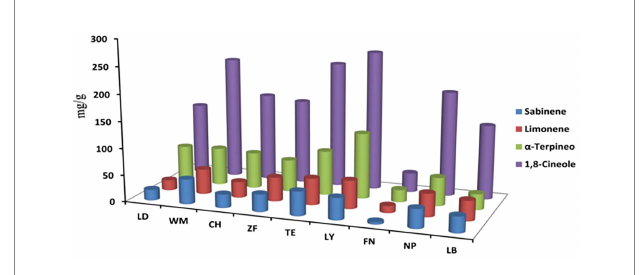
FIGURE 6 Content of medicinally important bioactive compounds of C. migao fruit across nine sites. The ANOVA analysis and Turkey were used to compare the soil chemical properties across nine sample sites. Different letters indicate significant differences ( p < 0.05 ; n = 5). Four bioactive compounds, 1,8-cineole (blue), sabinene (orange), limonene (grey), and α -terpineol (yellow), the length of the column represents the content of the bioactive compound.